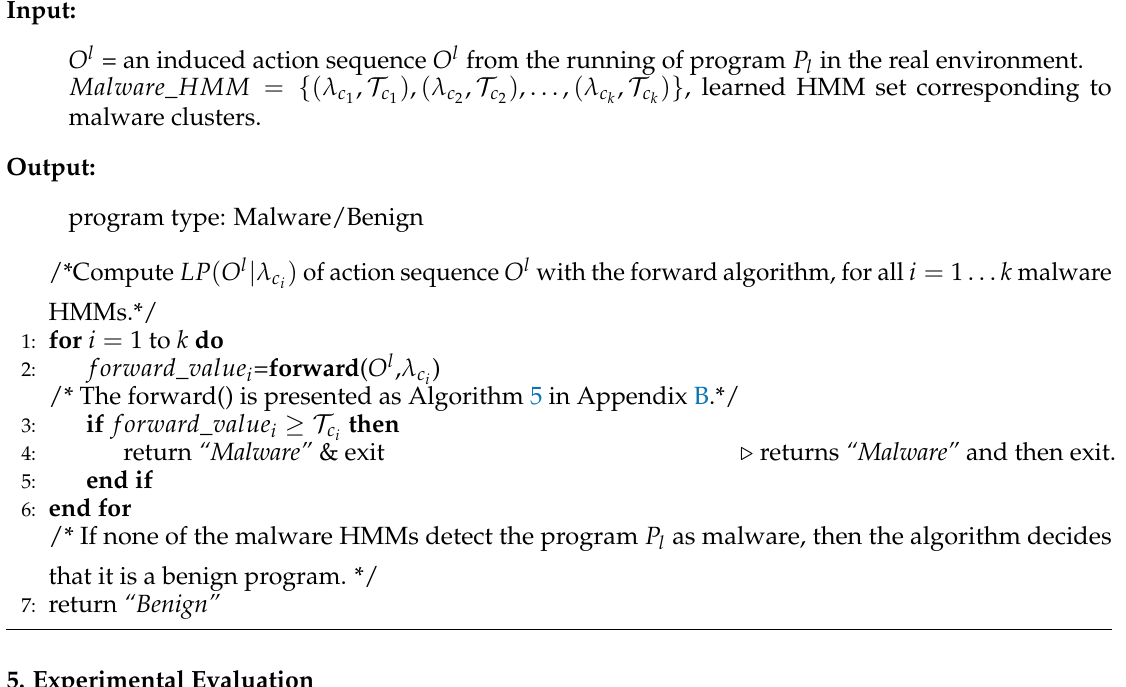
Algorithm 4 : HM 3 alD -Detection